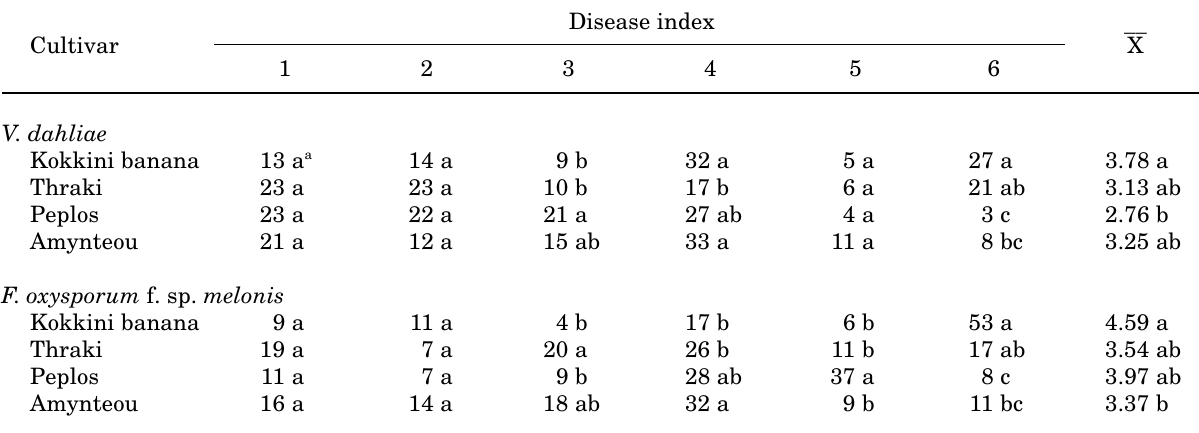
Table 4. Percentages of diseased plants in four melon cultivars infected with Verticillium dahliae and Fusarium oxysporum f. sp. melonis in each disease index category (1-6) in 1998 and 1999. Disease